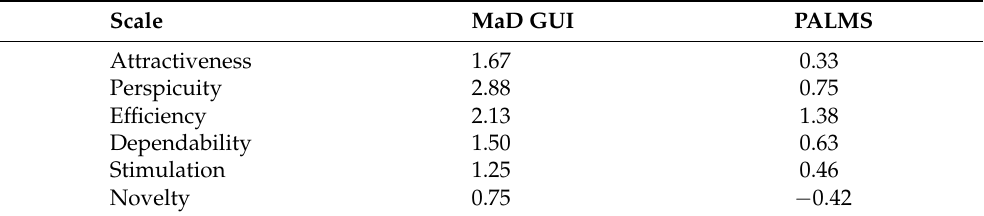
Table 4. User experience questionnaire median scores for the user interface study. For each item, a score between − 3 (worst) and 3 (best) is